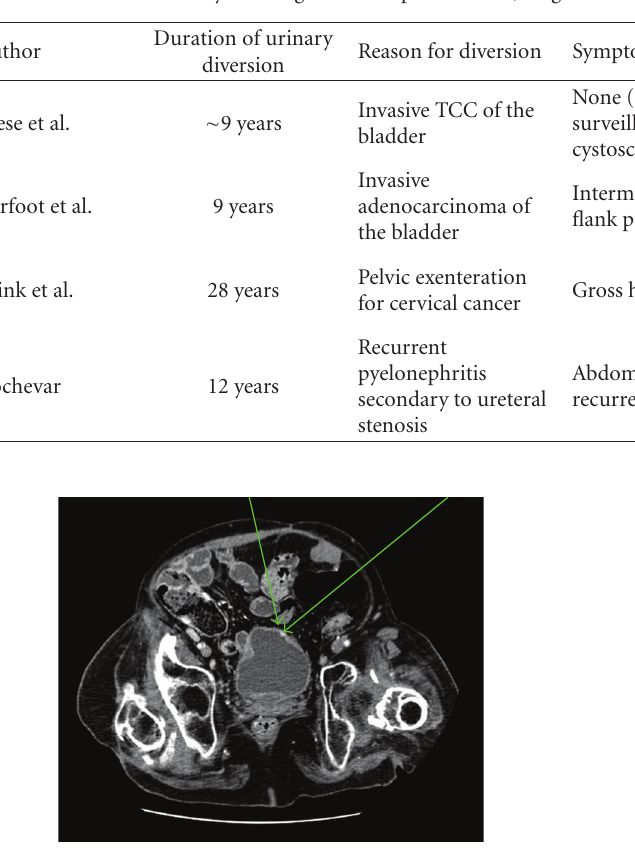
Figure 1: An arterial phase view of the carcinoid tumor seen on CT urogram. The tumor is located at the anterior portion of the cystoplasty along the bladder-ileum border (arrows pointing to area of concern for tumor).